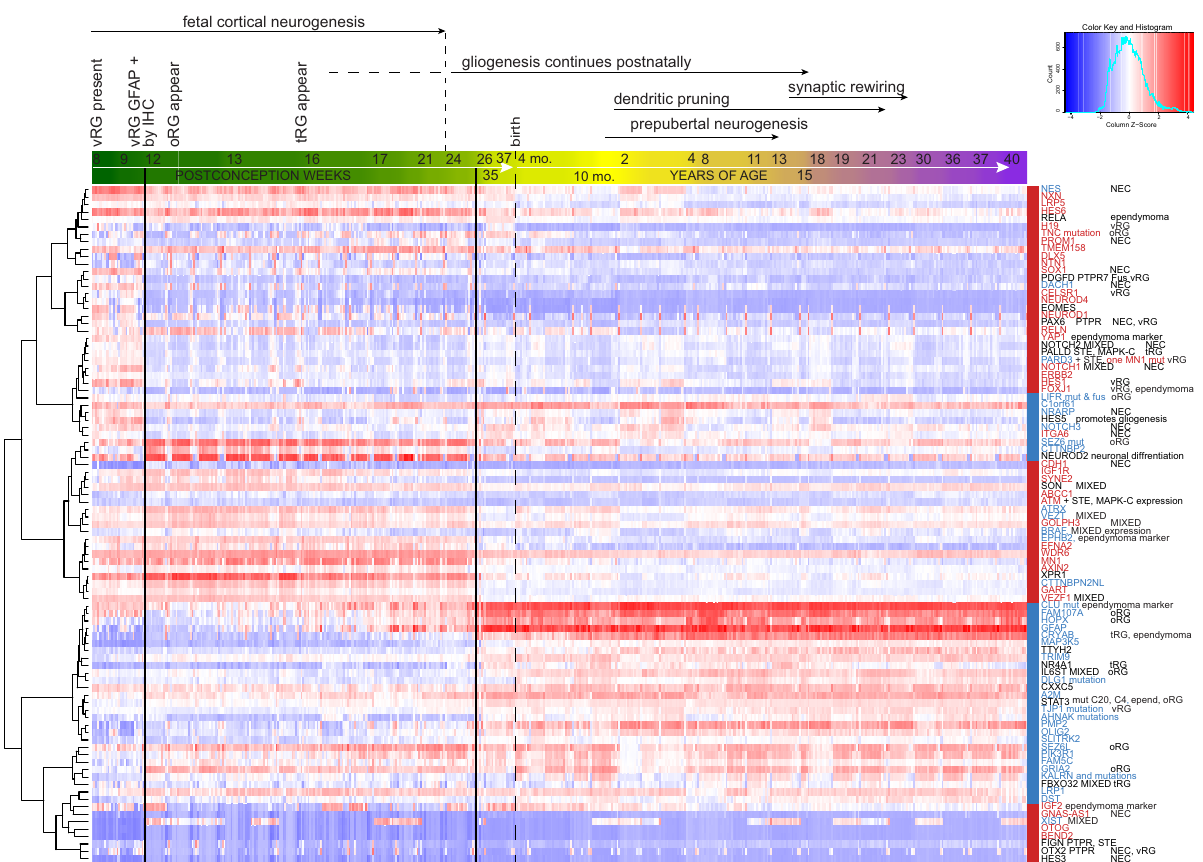
Fig. 5 MN1-BEND2 and MAPK-ABC tumor-associated genes demonstrate fetal age-speci fi c expression and cluster with vRG and oRG marker genes, respectively. The developmental expression time course of NSC markers and select genes overexpressed or mutated in MN1-BEND2 and MAPK-ABC AB- like tumors was obtained from the Allen Human Developmental Transcriptome database and subjected to unsupervised hierarchical clustering. MN1- BEND2 tumor-associated genes (relatively overexpressed or mutated) are depicted in red and MAPK-ABC tumor associated genes are in blue. Genes associated with NEC, vRG, tRG and oRG are indicated. The x-axis age bar progressive color scheme is arbitrary. Transcript expression is normalized by reads per kilobase of transcript per million mapped reads (RPKM) to compensate for RNAseq generation of more sequencing reads from longer RNA molecules. Data is from up to 16 brain regions from 42 specimens (Allen Human Brain Atlas Developmental Transcriptome, Institute for Brain Science, available from: human.brain-map.org). The fi gure source data is available in the Source Data